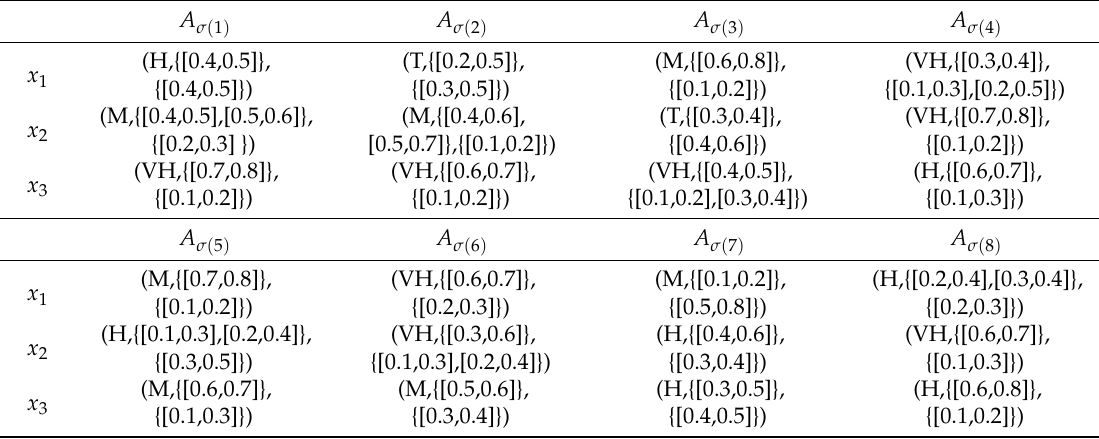
Table 7. The prioritized individual IVDHFUBL decision matrix R 3